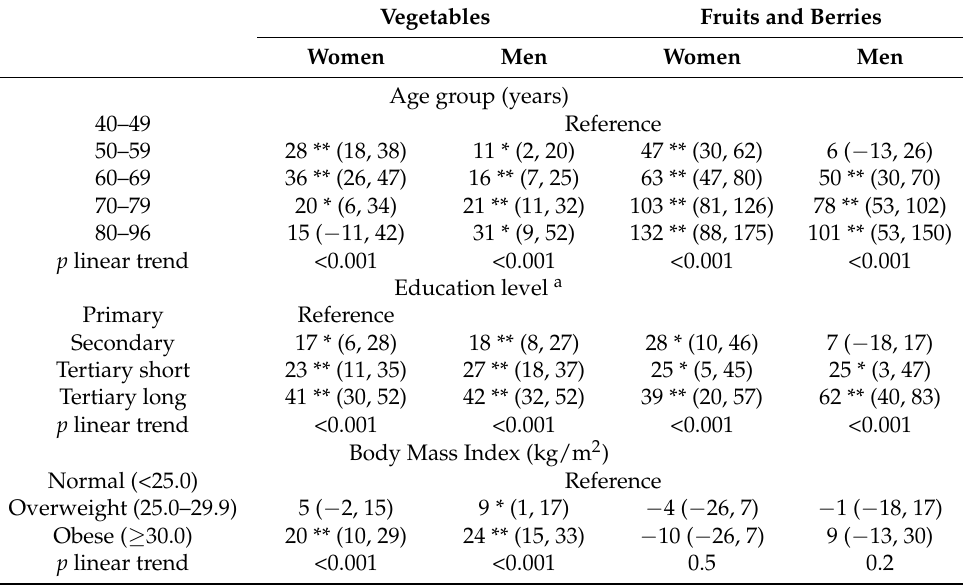
Table 4. Linear regression analysis of intake of vegetables and fruits/berries. The Tromsø